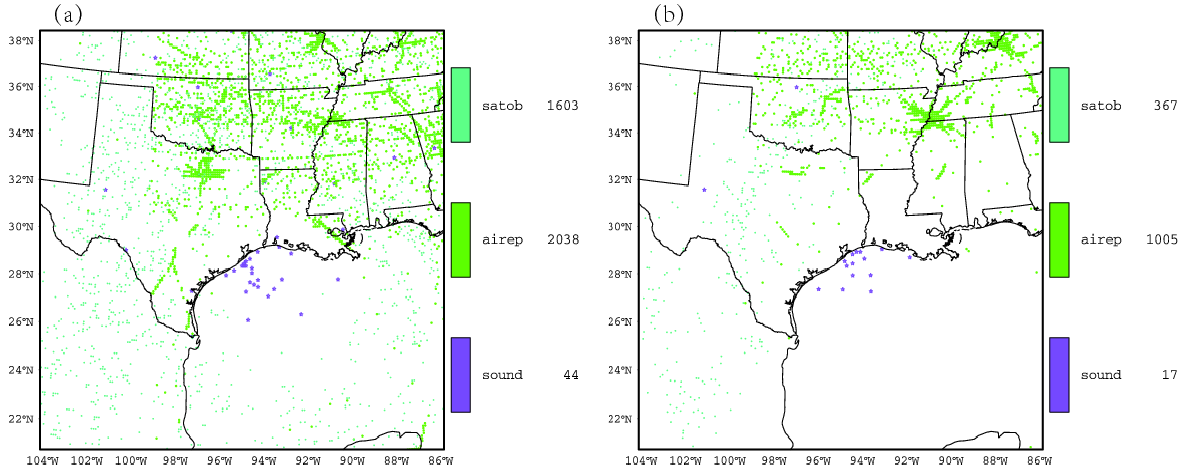
Figure 3. Distribution of conventional data ( a ) at 0000 UTC on 13 September; ( b ) at 0600 UTC on 13 September. SATOB (satellite atmospheric motion vectors), AIREP (aircraft data), SOUND (radiosondes).